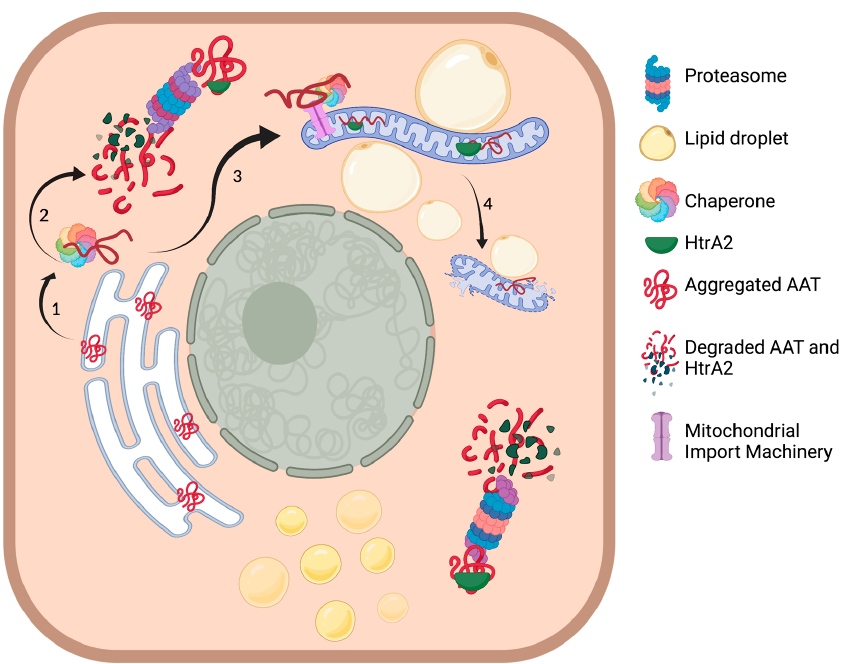
Figure 8. ZAAT-mediated mitochondrial injury within the hepatocytes. (1) Hsp70 binds to ZAAT to prevent aggregation of the mutated protein targeted for proteasomal degradation. (2) Proteasomal degradation of ZAAT. (3) Interaction of the cytoplasmic chaperone with mitochondrial import machinery leading to ZAAT mitochondrial translocation. (4) Disruption of mitochondrial membrane integrity and mitochondrial dysfunction. Figure was made by BioRender.